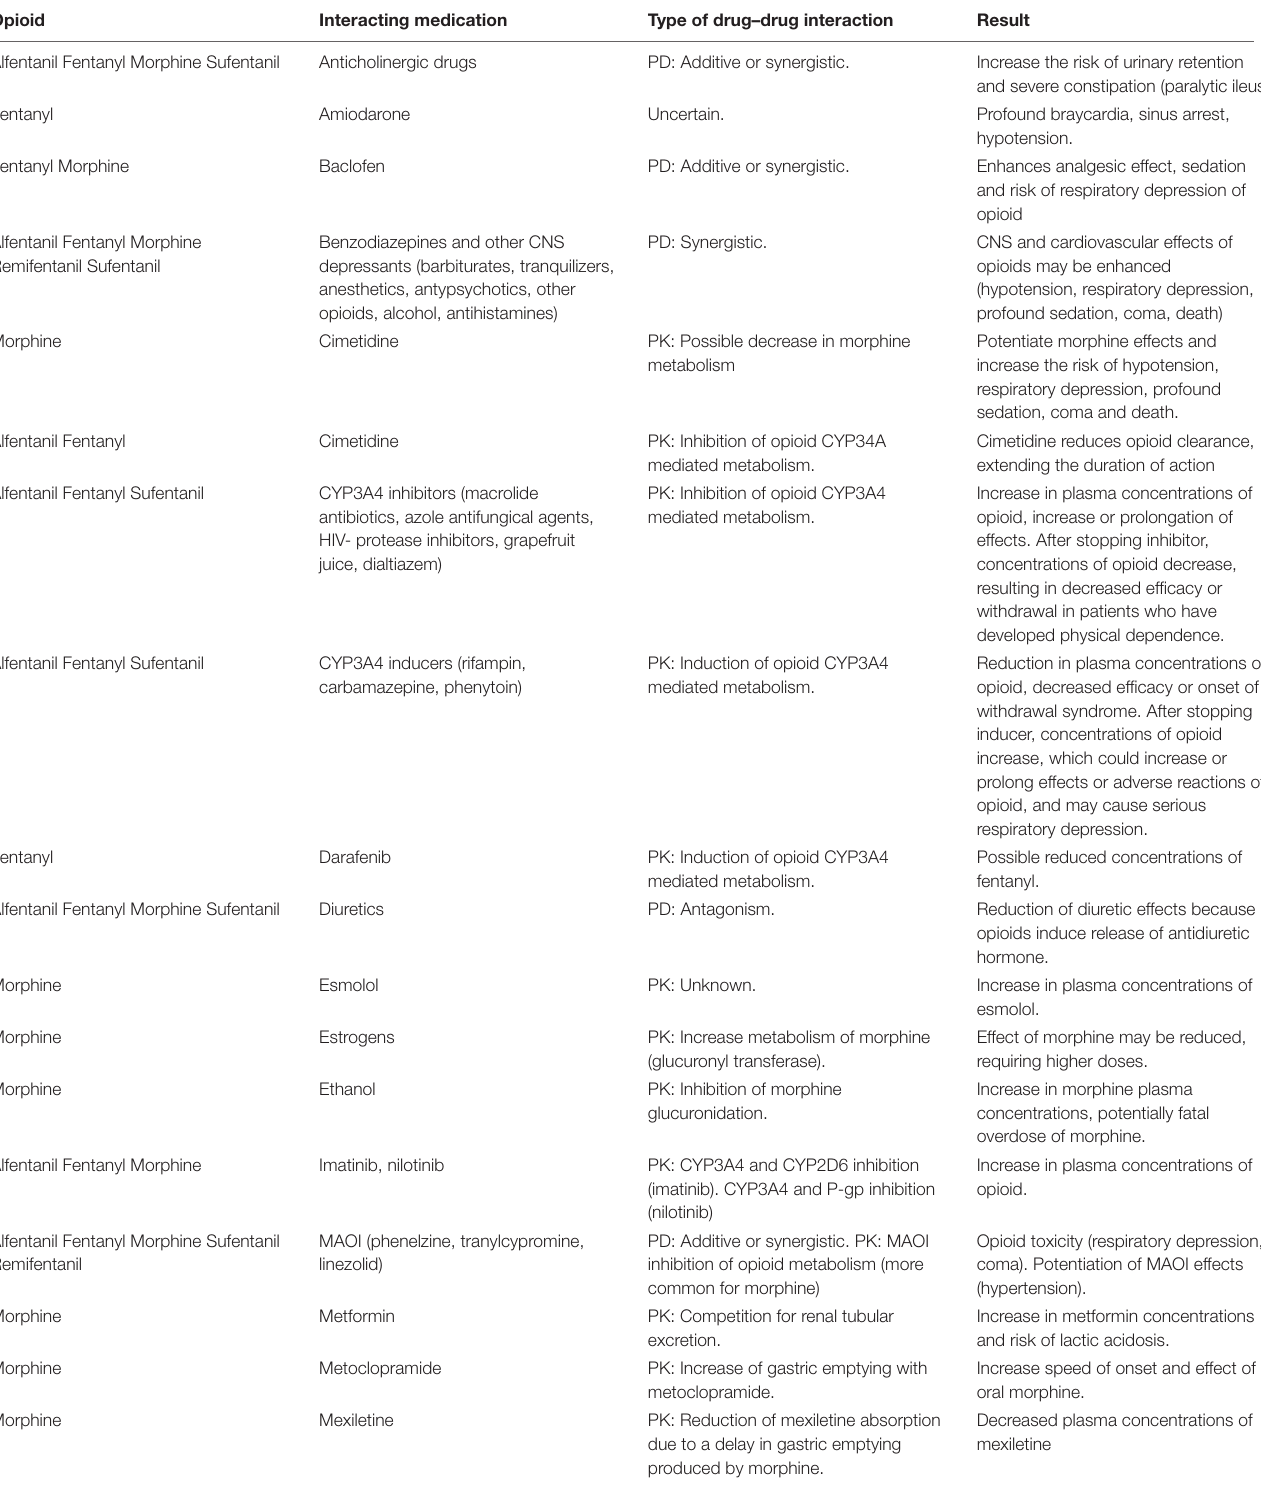
TABLE 2 | Drug–drug interactions with morphine, fentanyl and other pharmaceutical analogs (Mozayani and Raymon, 2004; Baxter, 2008; Preston, 2015; Karalliedde et al., 2016; Food and Drug Administration [FDA], 2018; European Monitoring Centre for Drugs and Drug Addiction [EMCDDA], 2018a). Opioid Interacting medication Type of drug–drug interaction